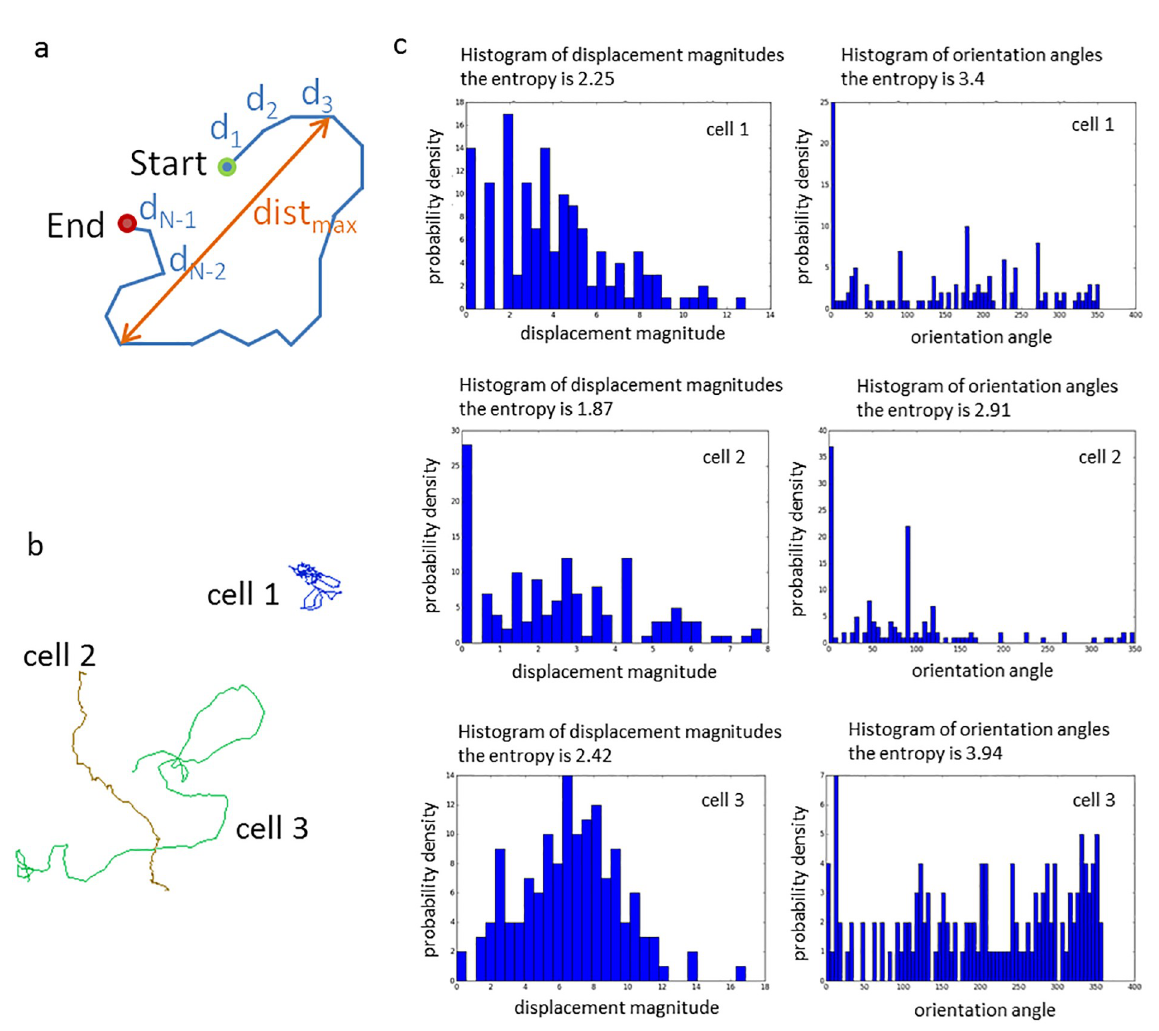
Fig 1. Illustration of motility parameters. (a) Schematic representation of the definition of the radial effectiveness e r which is computed as the quotient e r = (d 0 + d 1 + ... + d N-2 + d N-1 ) / dist max . (b) 3 selected trajectories of cell 1, cell 2 and cell 3 colour coded by their respective e r values (e r = 0.11, 0.61 and 0.33 for trajectories 1, 2 and 3, respectively). (c) For each trajectory depicted in (b) the histograms of their displacement lengths/magnitudes and of their orientation angles are shown. A more concentrated histogram leads to a smaller entropy value. Thus, for trajectory 2 the smallest entropy values are obtained (1.87 and 2.91) and for trajectory 3 the highest ones (2.42 and 3.94).